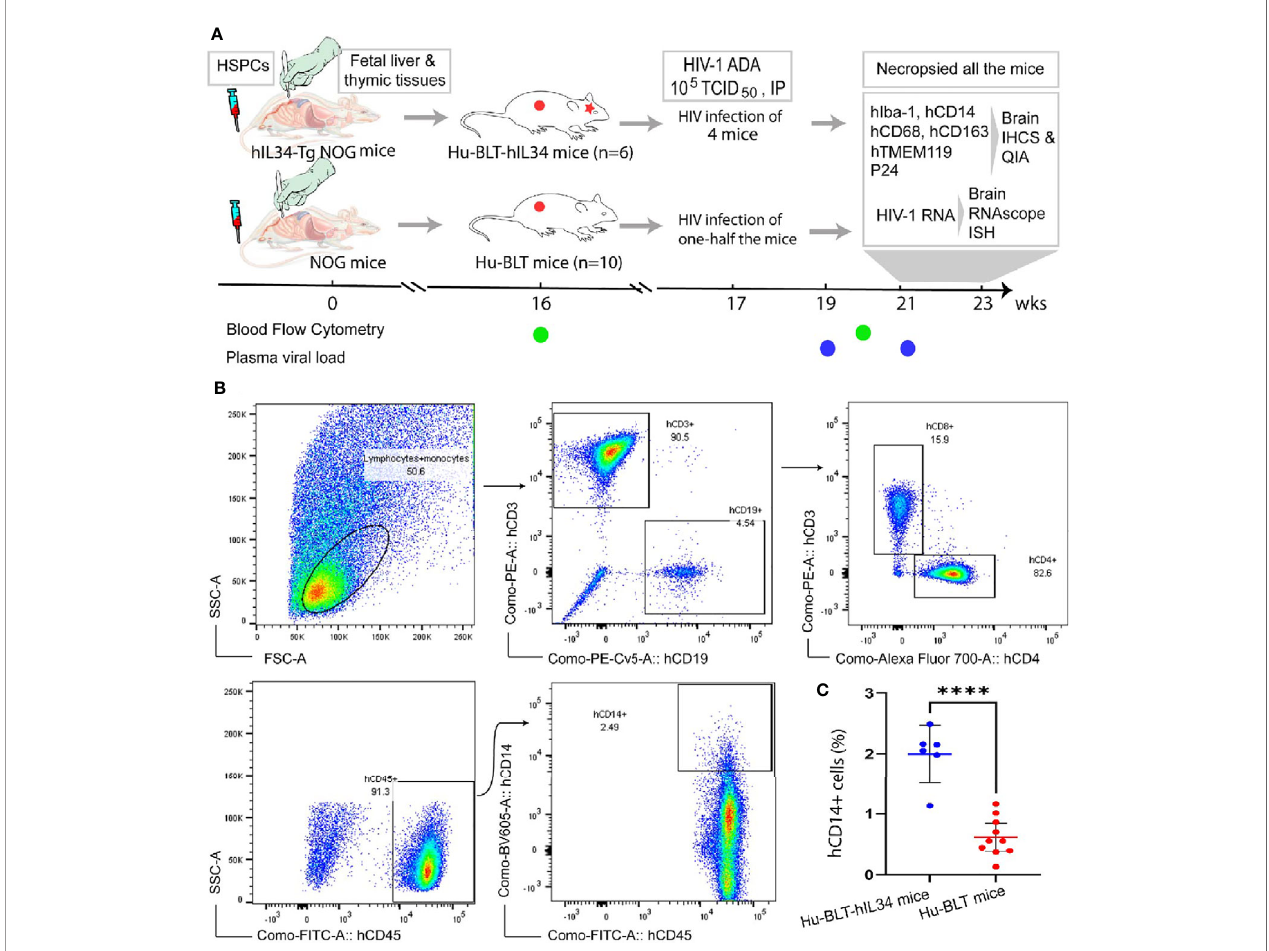
FIGURE 1 | Experimental timeline and Flow Cytometric evaluation of human immune cells reconstitutions in the peripheral blood of hu-BLT-hIL34 and hu-BLT mice. (A) Experimental design and timeline for the humanization of hIL34 transgenic mice and NOG mice by engrafting with human CD34+ hematopoietic stem and progenitor cells (HCSPs) and human fetal liver and thymic tissues, HIV-1 Ada infection of some mice in each group, and the evaluation of human myeloid and microglial cell reconstitution and HIV-1 infection in the CNS of euthanized mice using immunohistochemical staining (IHCS) and RNAscope in situ hybridization (ISH). (B) The representative fl ow cytometric dot plots of the peripheral blood mononuclear cells of a hu-BLT-hIL34 mouse (#1703) at the 4 months after transplantation, which were gated with hCD45+, hCD3+, hCD9+, and hCD14+ cells. (C) The percentage of hCD14+ myeloid cells in the peripheral blood of hu-BLT-hIL34 mice is signi fi cantly higher than that hu-BLT mice at the 4 months post transplantation. Each symbol represents an individual mouse, hu-BLT-hIL34 mice n=6, hu-BLT mice n=10; ****p <